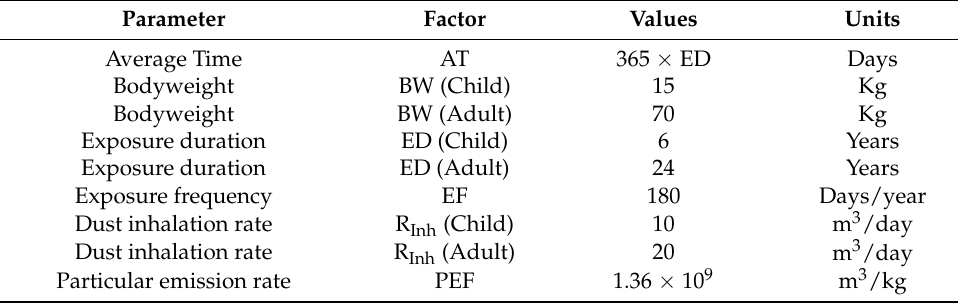
Table 7. Carcinogenic and non-carcinogenic indices parameters.